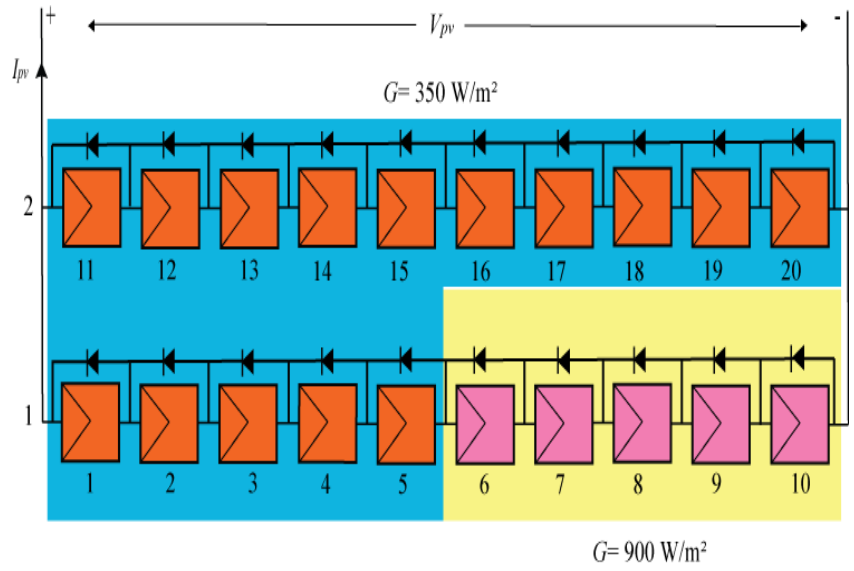
Figure 14. Shading patterns for scenario two.